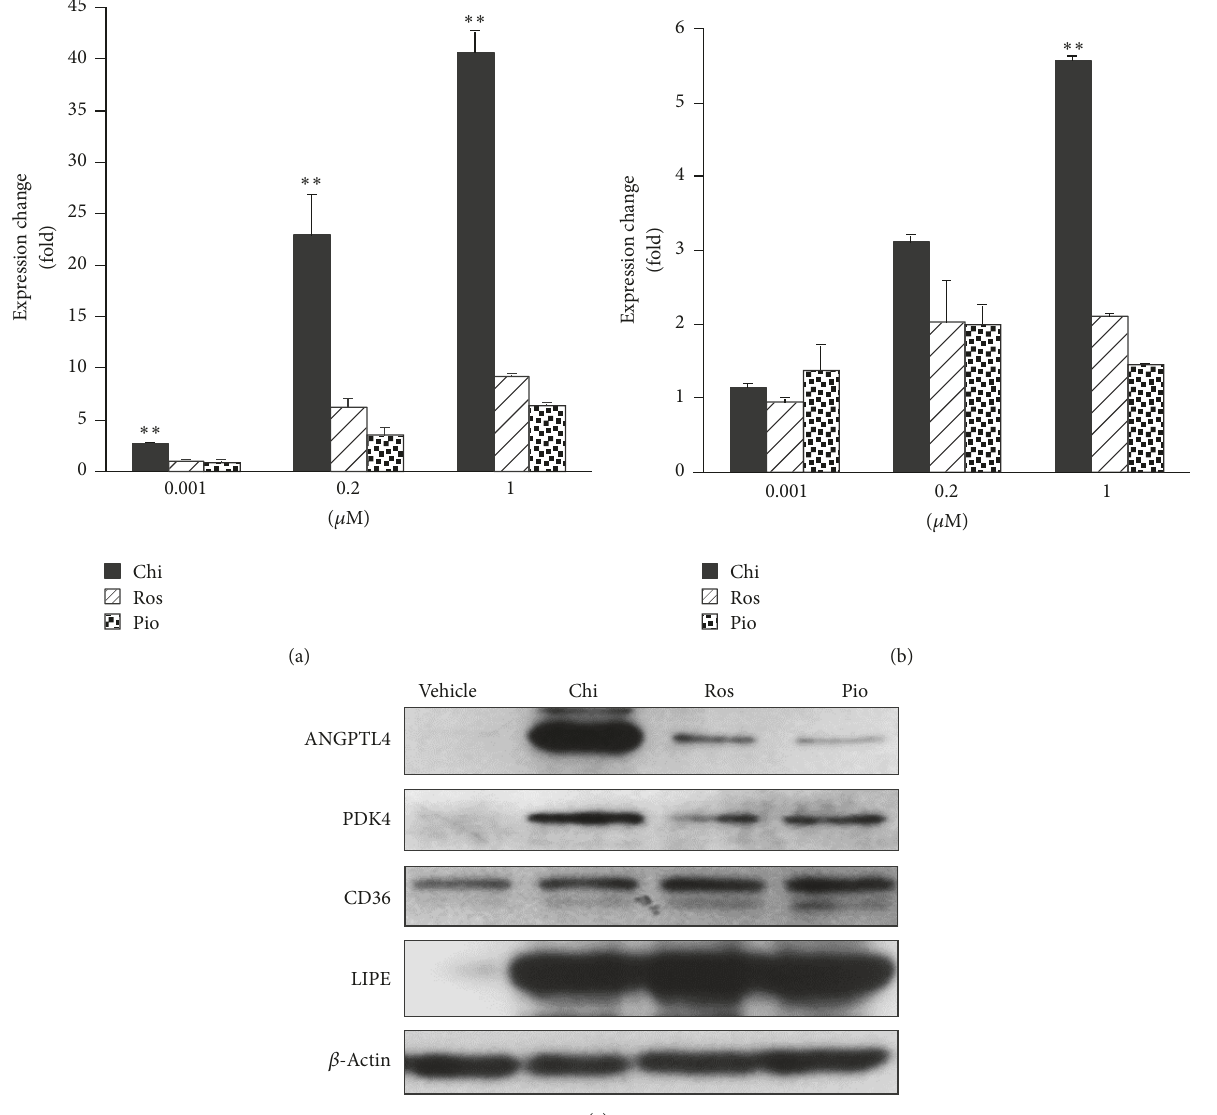
Figure 1: Preferential induction of ANGPTL4 and PDK4 mRNA and protein by chiglitazar. (a) and (b) Human preadipocyte HPA-v cells were incubated with different concentrations of the three agonists for 24 hours before total RNA was collected and purified. Real-time RT-PCR was performed as described in Materials and Methods . The dose-dependent changes in ANGPTL4 (a) and PDK4 (b) expression induced by the different agonists were normalized against the sample treated with vehicle (0.01% (vol/vol) DMSO) only. (c) HPA-v cells were incubated with 1 𝜇 M of each agonist for 48 hours. Protein levels were assessed by immunoblot analysis using the respective primary antibodies ( 𝛽 -Actin, 1:1000; LIPE, 1: 1000; CD36, 1: 1000, PDK4, 1: 500; ANGPTL4, 1: 500) as described in Materials and Methods . Chi: chiglitazar; Ros: rosiglitazone; Pio: pioglitazone; LIPE: lipase, hormone-sensitive (HSL). Data represent the average and standard deviation of three independent experiments. ∗∗ represents statistically significant differences in expression induction by Chi relative to Ros and Pio ( 𝑝 < 0.01